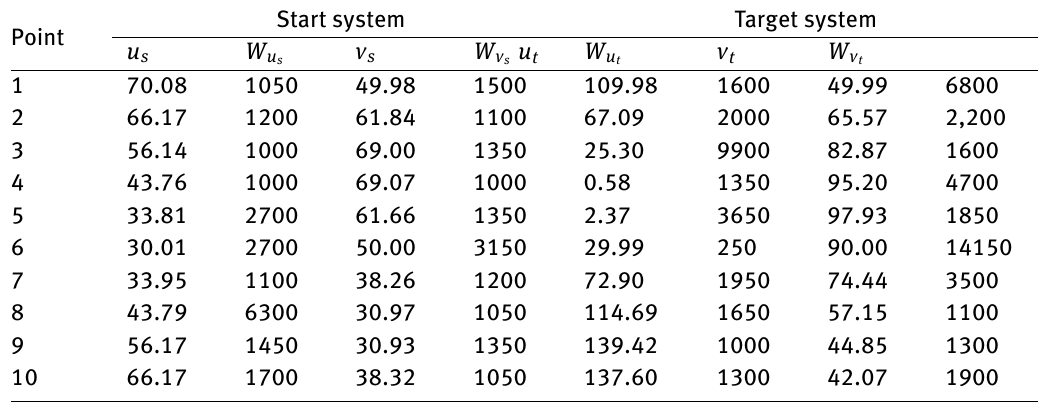
Table 1: The observations in start and target system and corresponding weight from Amiri-Simkooei (2013).